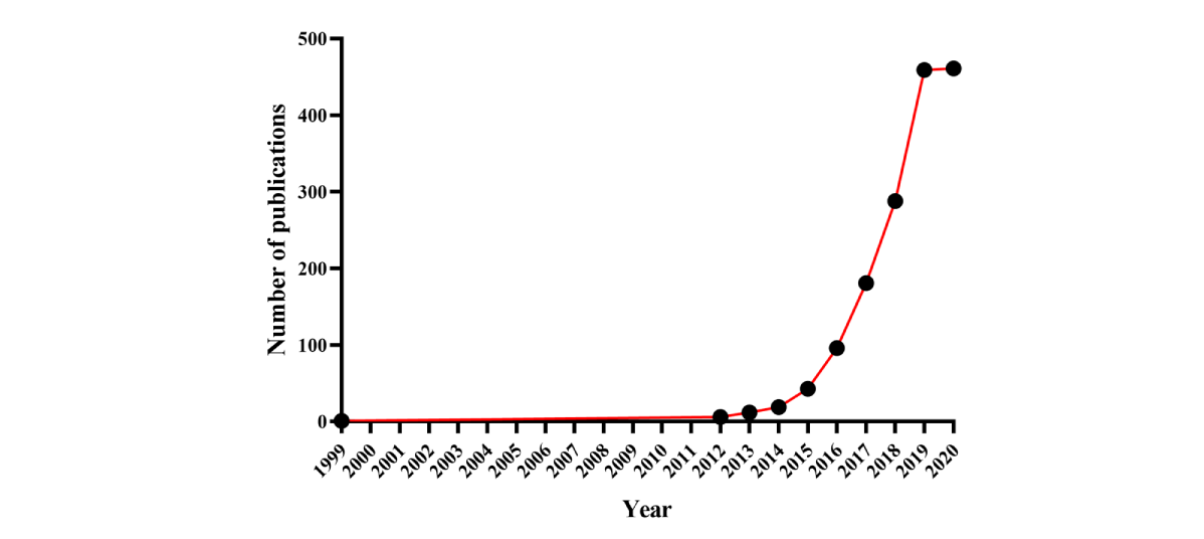
Figure 2. The trends in publications on clinical cancer research in mainland China from the Surveillance, Epidemiology, and End Results database between 1999 and